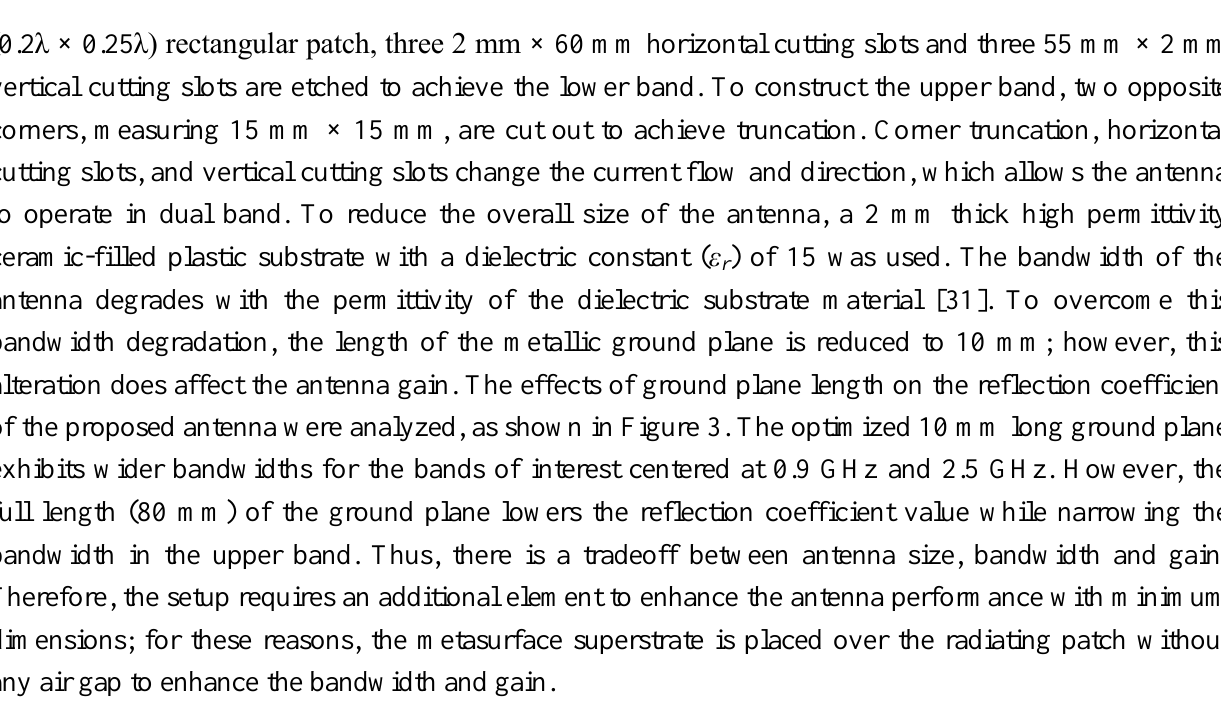
Figure 2. Schematic of the radiating